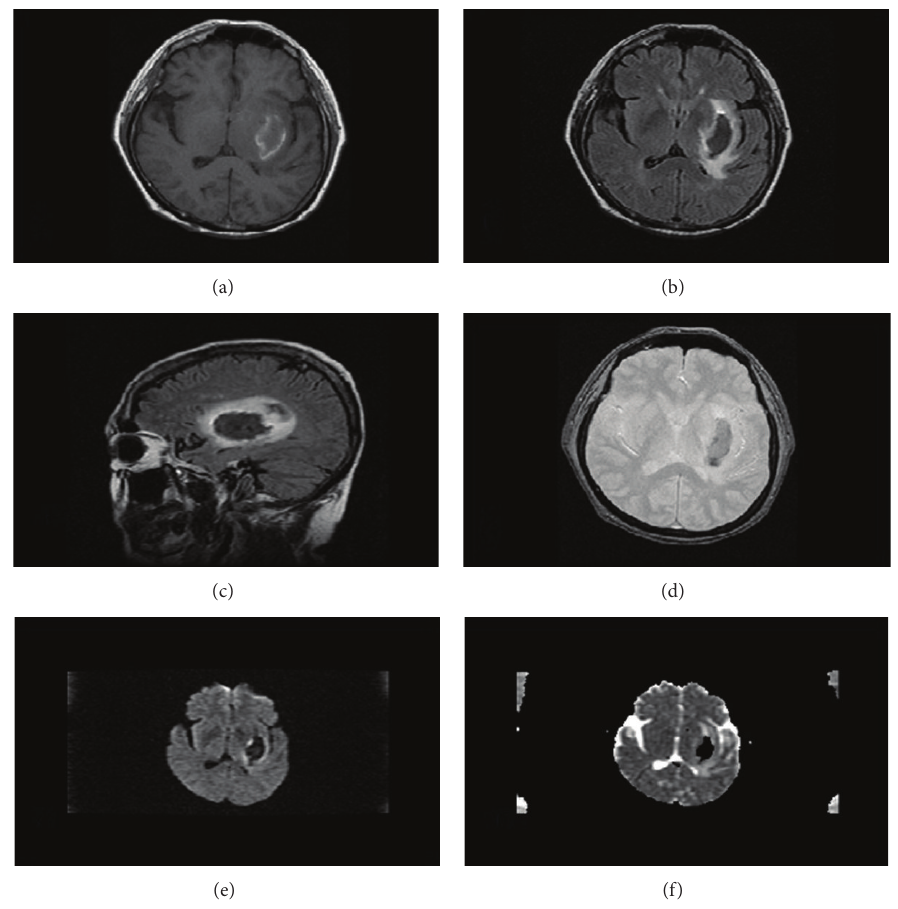
Figure1:Brainmagneticresonanceimagingshowingaleftintracranialhemorrhage.(a)AxialT1weightedimage,(b)axialT2weightedimage, (c)sagittalT1weightedimage,(d)axialgradientecho(GRE)image,(e)axialdiffusionweightedimage,(f)adjusteddiffusioncoefficient(ADC)